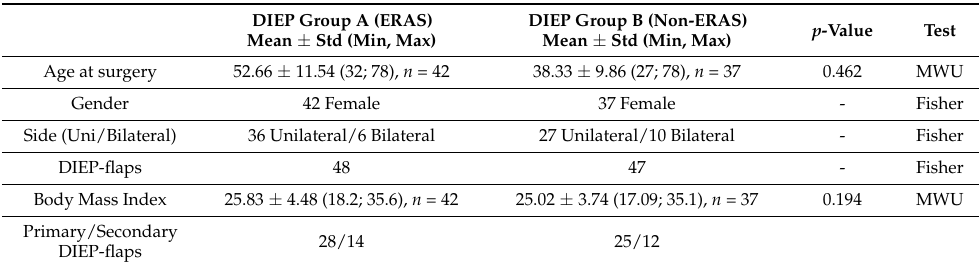
Table 1. Demographic data for the study groups.